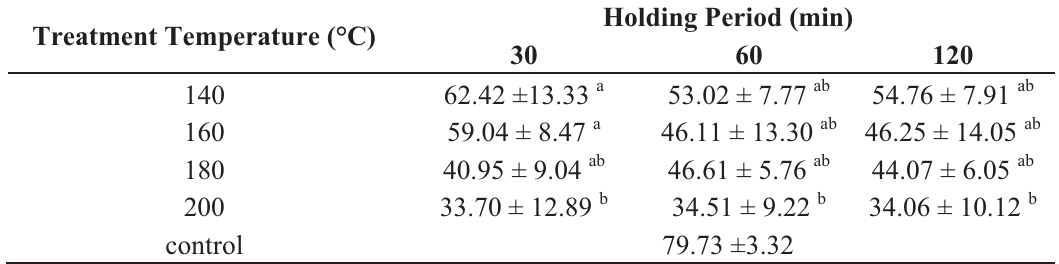
Table 1. Summary of % mass loss after a 16-week exposure of D. asper to M. losbañosensis . Treatment Temperature